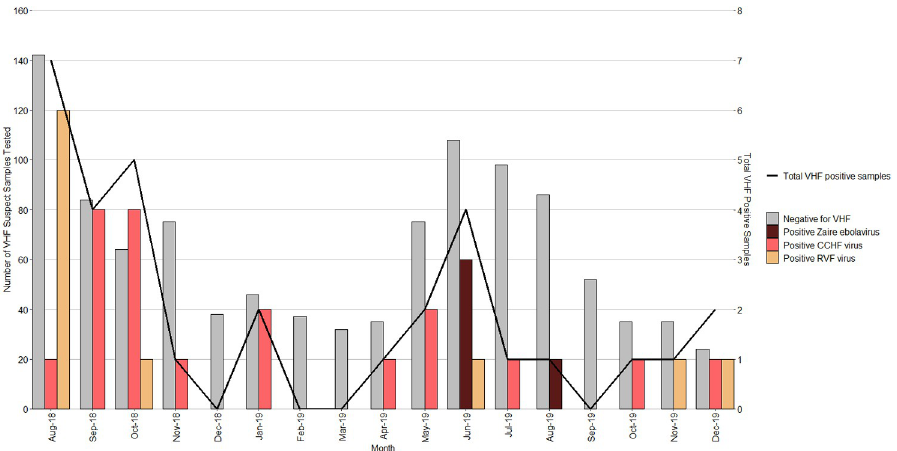
Fig 3. VHF pathogens detected during first year of EVD preparedness period in Uganda 1 st August 2018 – 30 th December